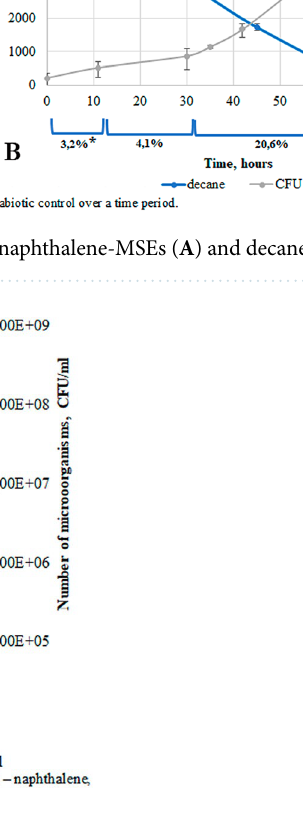
Figure 4. Growth parameters of the P. veronii 7–41 in